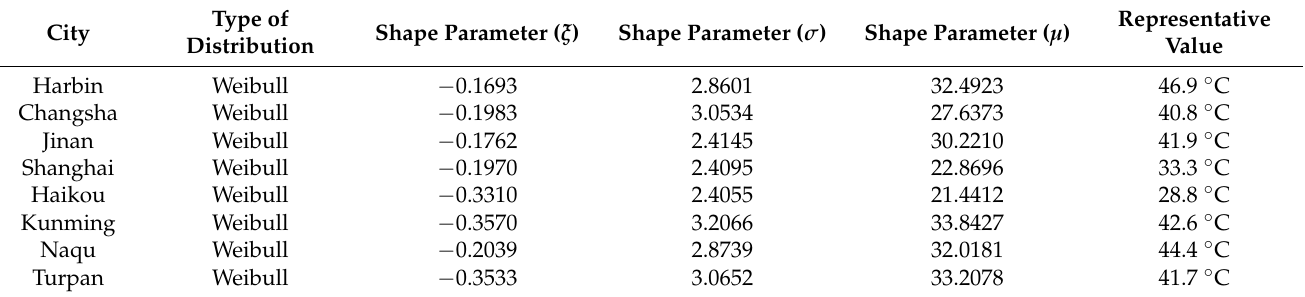
Table 4. Parameters of fitted PDF curves and the representative values of daily temperature